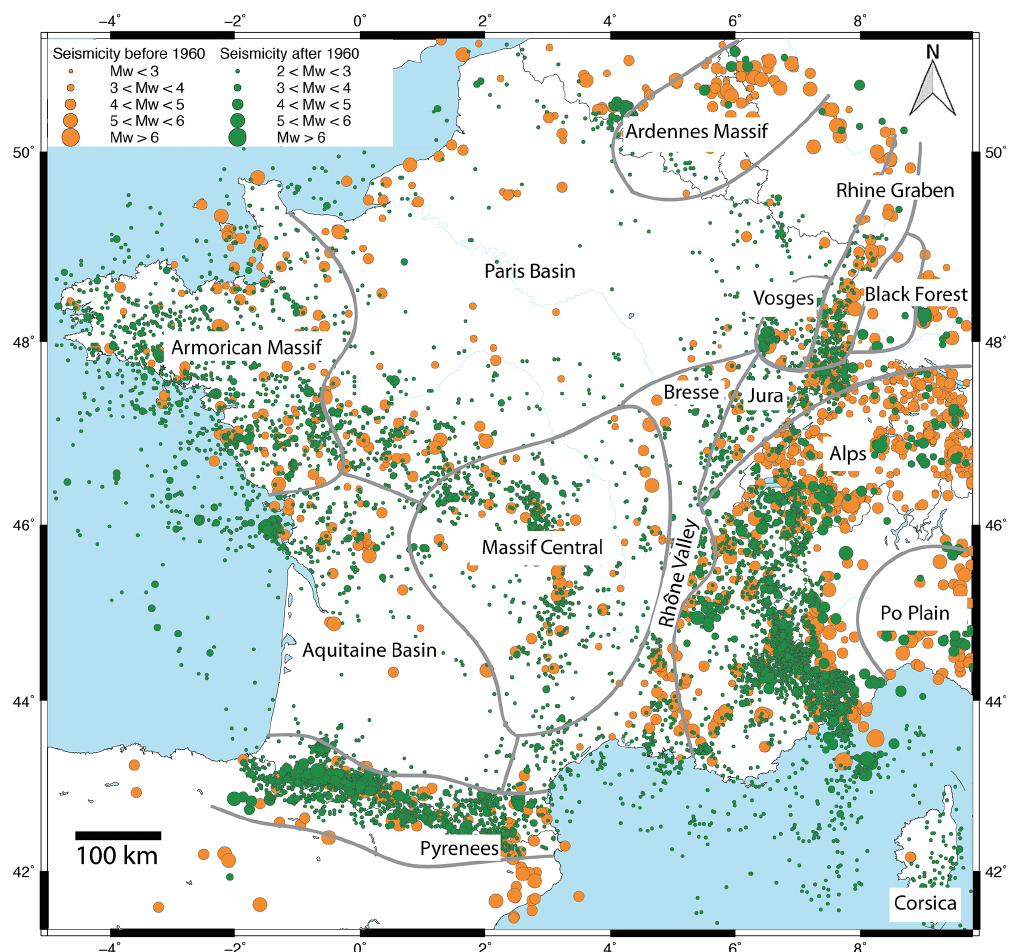
Figure 1. Map of instrumental in green and historical in orange seismicity (SHARE (Seismic Hazard Harmonization in Europe) and SI-Hex (Sismicité Instrumentale de l’Hexagone)). Gray lines delimit the main geological